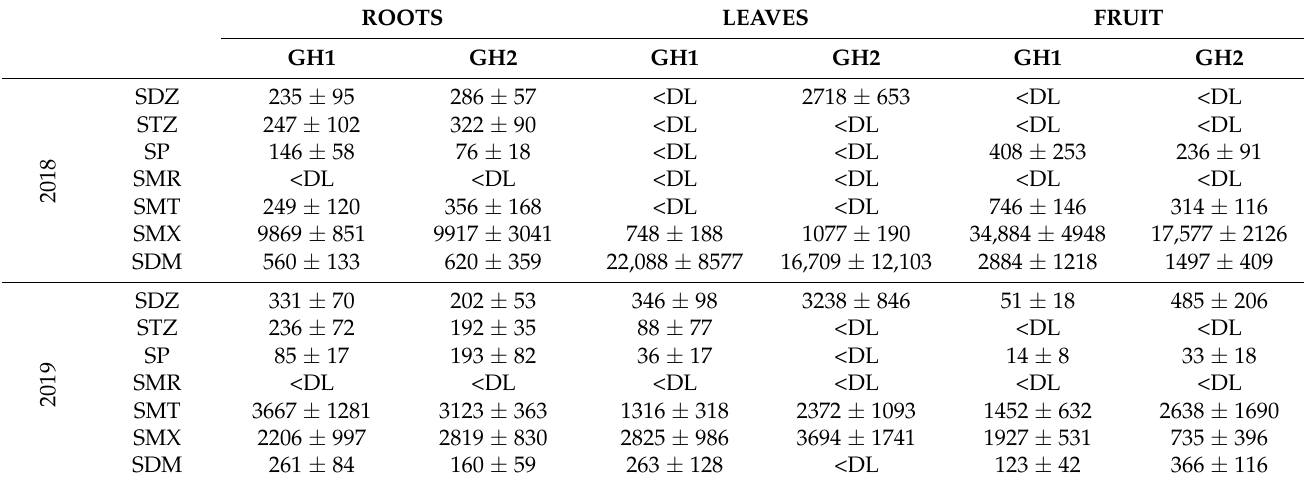
Table 5. Concentration of sulfonamides (sulfadiazine (SDZ), sulfathiazole (STZ), sulfapyridine (SP), sulfamerazine (SMR), sulfamethizole (SMT), sulfamethoxazole (SMX) and sulfadimethoxine (SDM)) in tomato plants (ng kg − 1 ) over two years. Data are represented as the mean ± standard deviation. <DL indicates below the detection limit. ROOTS LEAVES FRUIT GH1 GH2 GH1 GH2 GH1